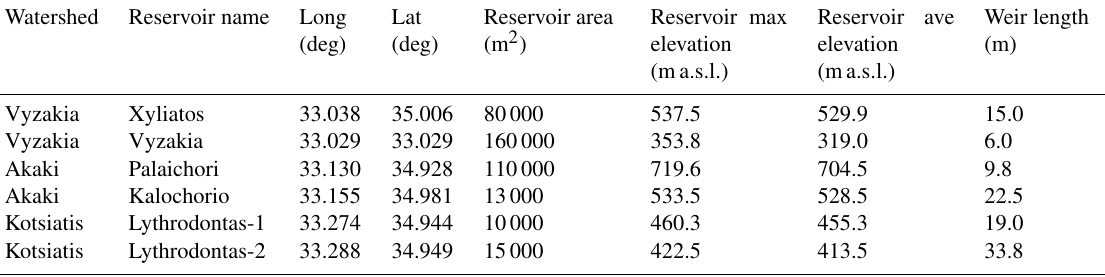
Table 3. Characteristics of the reservoirs included in the WRF-Hydro simulations; Long and Lat are longitude and latitude, respectively. Watershed Reservoir